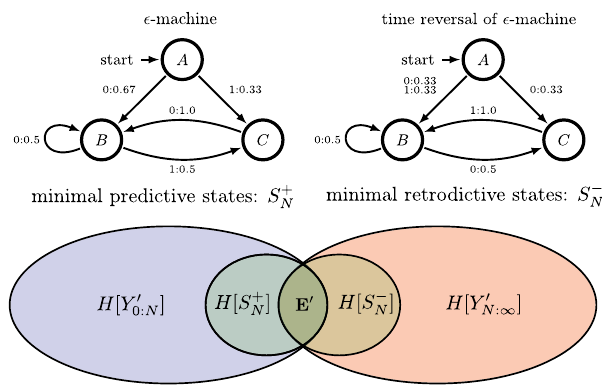
FIG. 5. Alternate minimal generators of the golden mean process: predictive and retrodictive. (Left) The ϵ -machine has the minimal set of causal states S þ required to predictively generate the output process. As a result, the uncertainty H ½ S þ (cid:2) is N contained by the uncertainty H ½ Y 0 0 ∶ (cid:2) in the output past. (Right) N The time reversal of the reverse-time ϵ -machine has the minimal set of states required to retrodictively generate the output. Its states are a function of the output future. Thus, its uncertainty H ½ S − (cid:2) is contained by the output future ’ s uncertainty H ½ Y 0 (cid:2) N N ∶∞